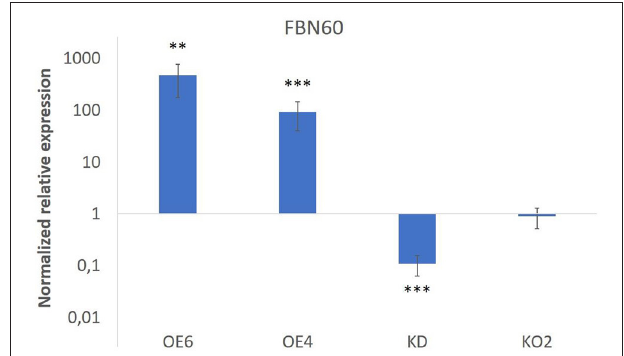
FIGURE 1 | F-Box Nictaba transcript levels in transgenic lines. Results represent the fold change (and SE) for FBN60 transcripts in transgenic lines compared with WT plants. Asterisks indicate statistically significant differences between WT and transgenic lines (** p ≤ 0.01; *** p ≤ 0.001). WT, wild-type